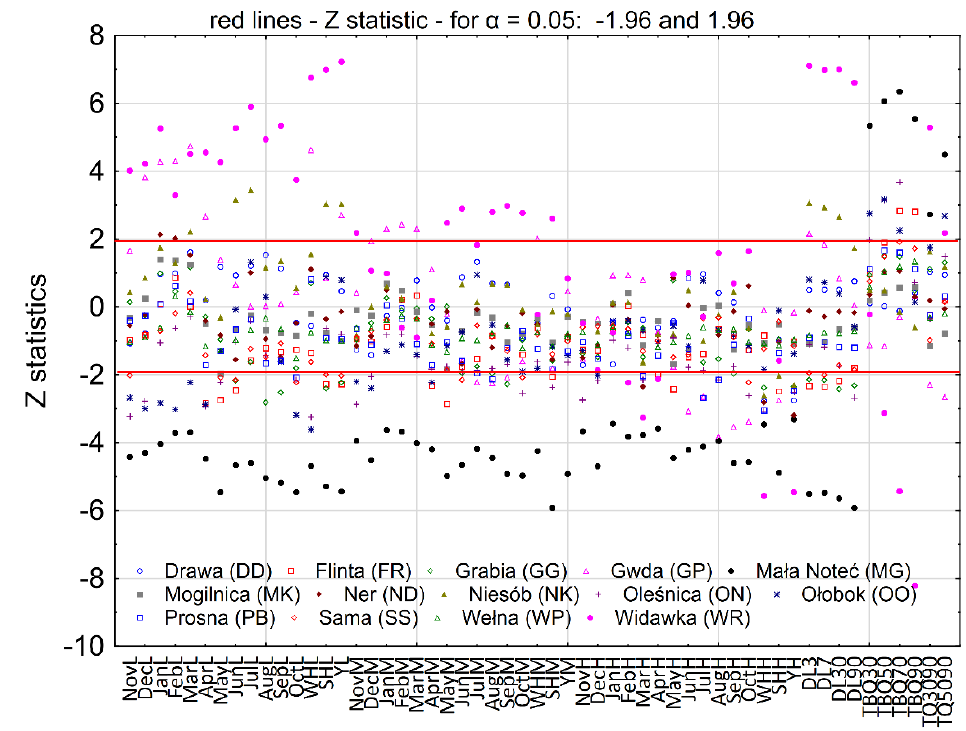
Figure 3. Z-statistic values for the analysed flow indices from 1951 to 2020.